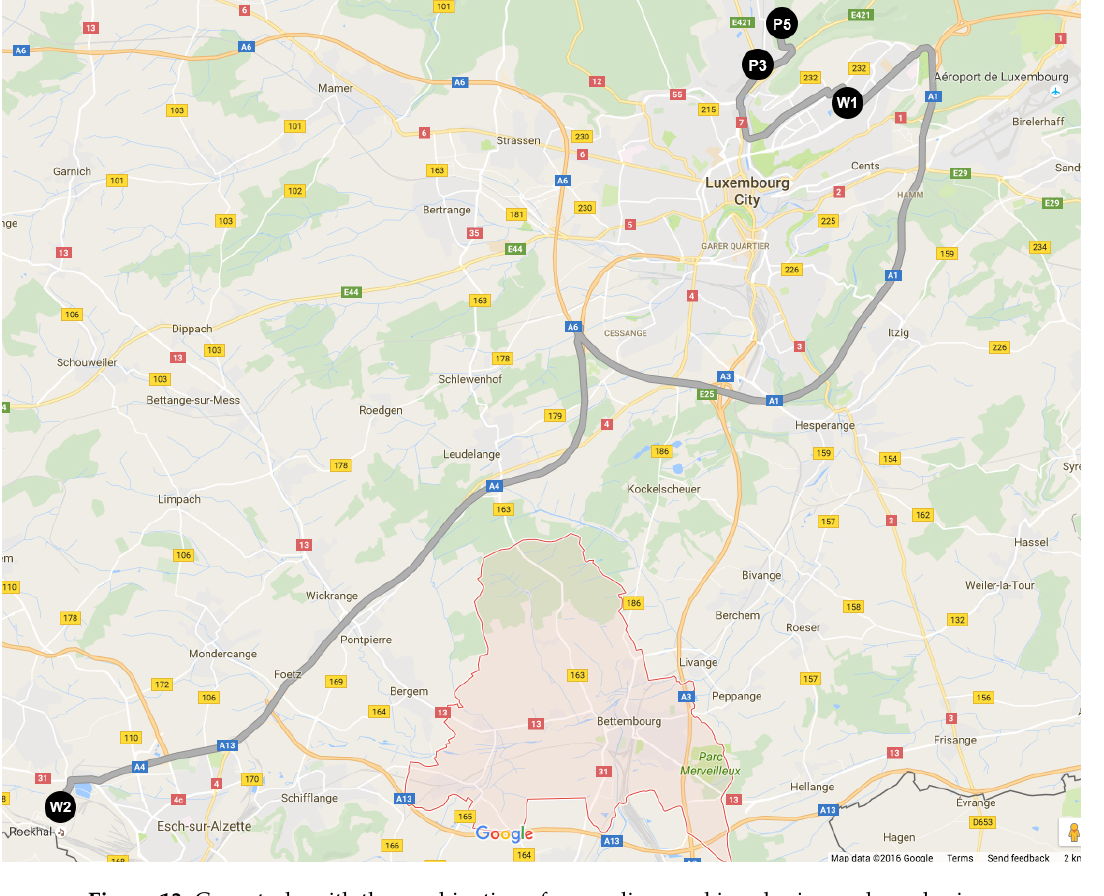
Figure 13. Case study with the combination of carpooling, parking sharing and car